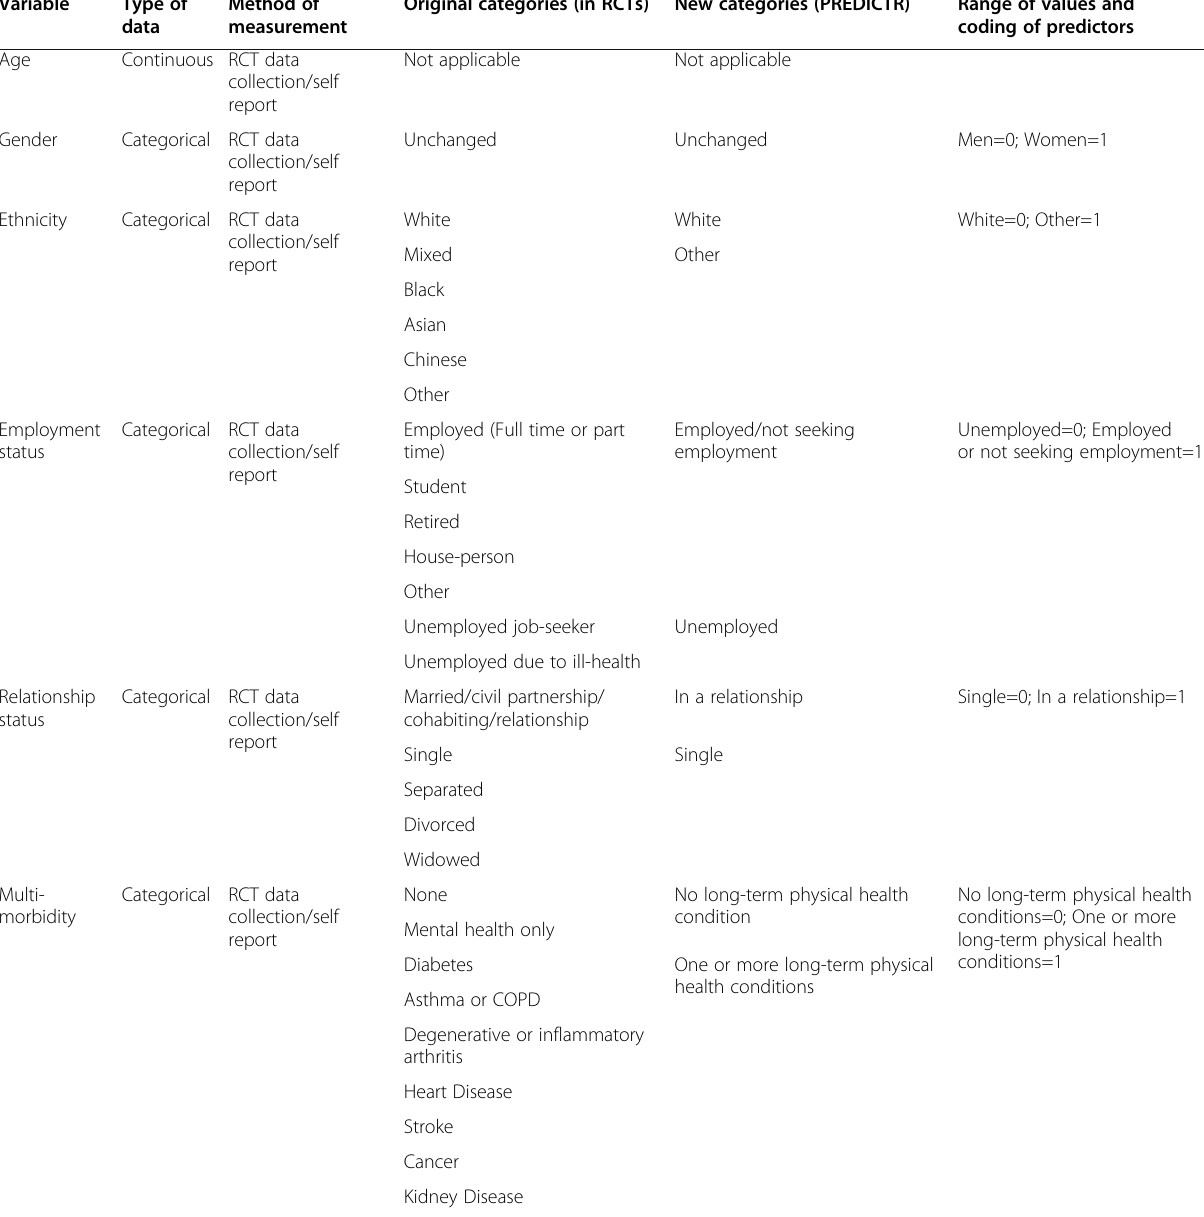
Table 3 Summary and categorisation of exploratory predictors